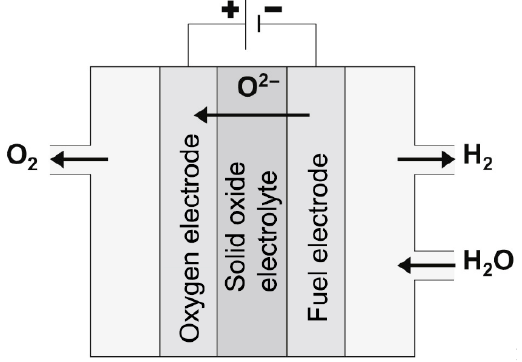
Figure 1. Scheme of a solid oxide electrolysis cell (adapted from